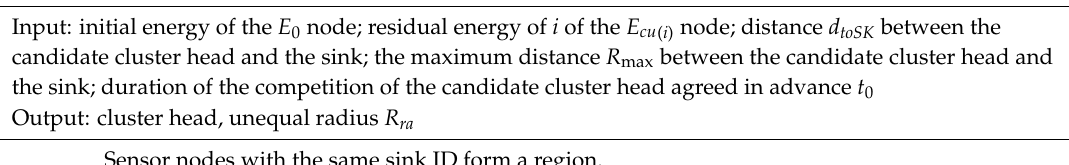
Algorithm 1: UCEBA Algorithm: unequal cluster